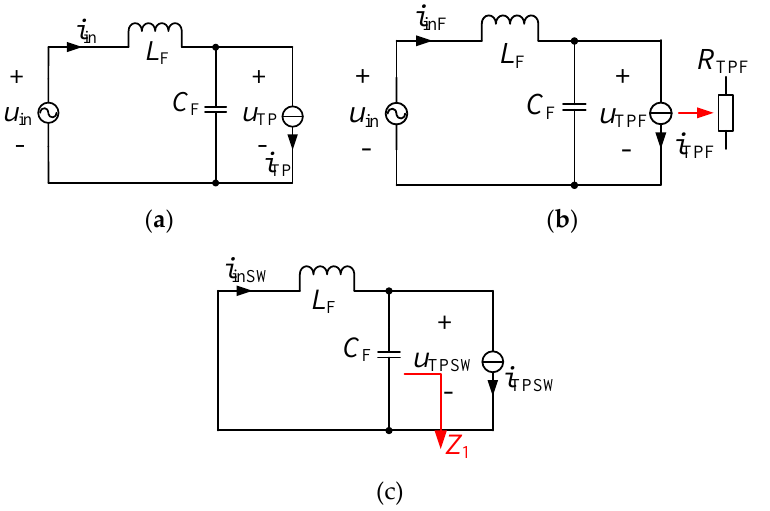
Figure 5. ( a ) AC side equivalent circuit of SSC. ( b ) The equivalent circuit when the fundamental component works alone. ( c ) The equivalent circuit when the harmonic component works alone.